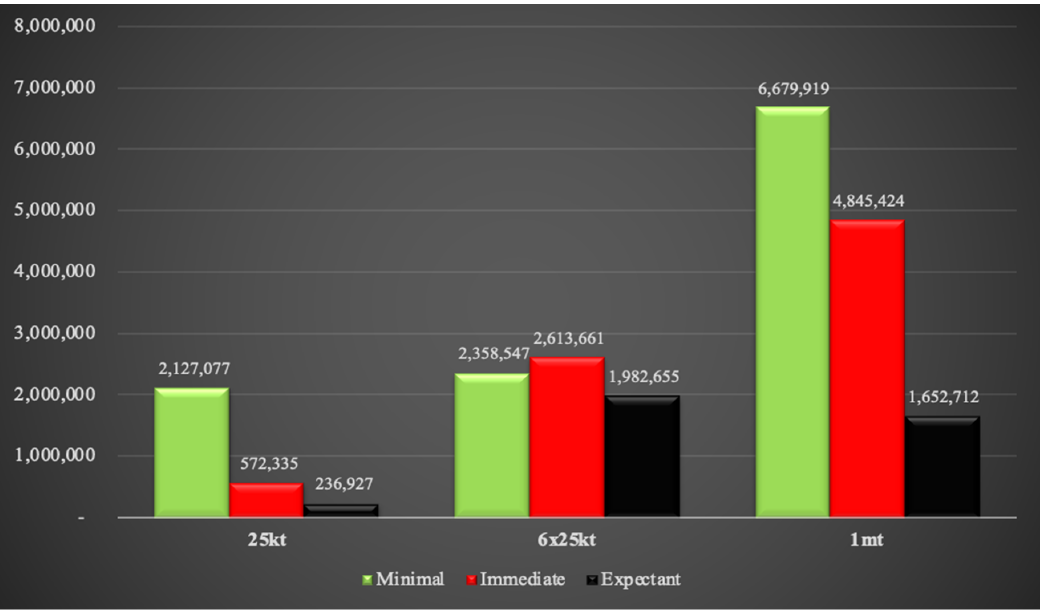
Figure 11. Combined injuries based on triage assignments.